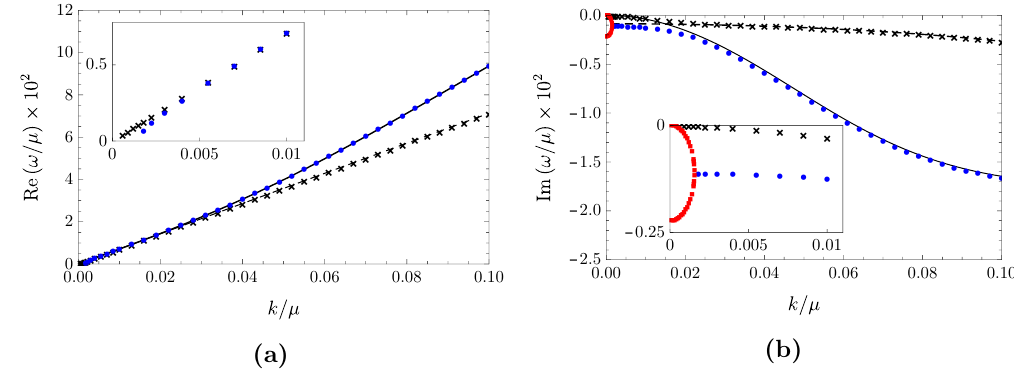
Figure 5. Dispersion relations of the four highest poles for (cid:28) = 10 (cid:0) 4 , ~ (cid:11) = 1, T=(cid:22) = 10 (cid:0) 2 , and 10 (cid:0) 4 (cid:20) k=(cid:22) (cid:20) 0 : 1. (a) Re ( ! ) =(cid:22) and (b) Im ( ! ) =(cid:22) , each versus k=(cid:22) . The solid and dashed black lines show the poles in G tt and G J in the probe limit, respectively. The black crosses follow the probe HZS dispersion for large k=(cid:22) , with (cid:0) from eq. (3.2), and the hydrodynamic sound dispersion for small k=(cid:22) , with (cid:0) in eq. (3.3). At large k=(cid:22) the blue dots have the dispersion of the poles in p G tt , with Re ( ! ) = (cid:6) k , but at k=(cid:22) (cid:25) 0 : 02 have Re ( ! ) = (cid:6) k= 2, and for k=(cid:22) . 0 : 02 they drop to Re ( ! ) = 0 around k=(cid:22) (cid:25) 2 (cid:2) 10 (cid:0) 3 , as shown in the inset of (a). They then split into two purely imaginary poles, the red squares, as shown in the inset of (b). One of these moves up the imaginary axis and becomes the charge di(cid:11)usion pole, with the probe limit dispersion in eqs. (3.4) and